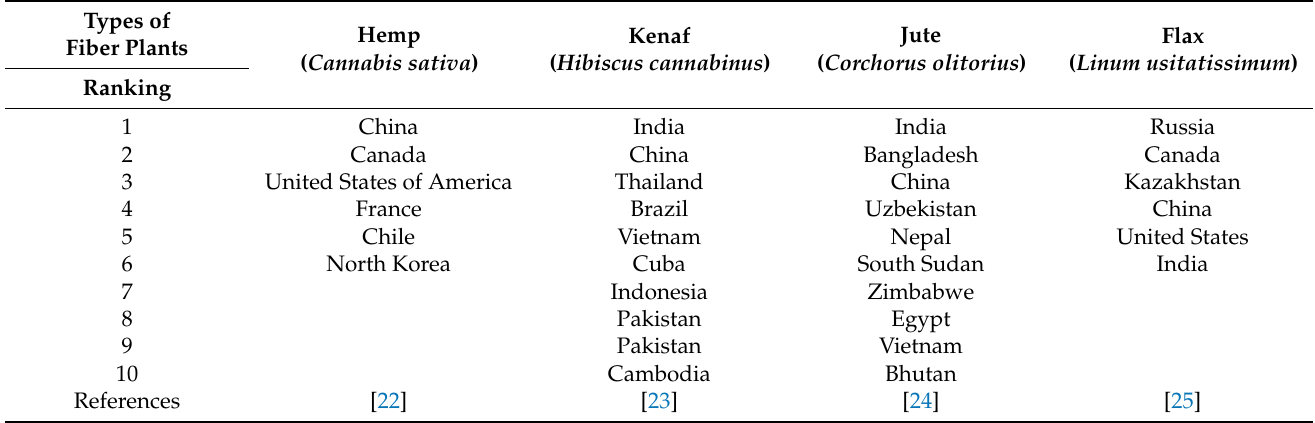
Table 2. World countries ranking of producing fibre